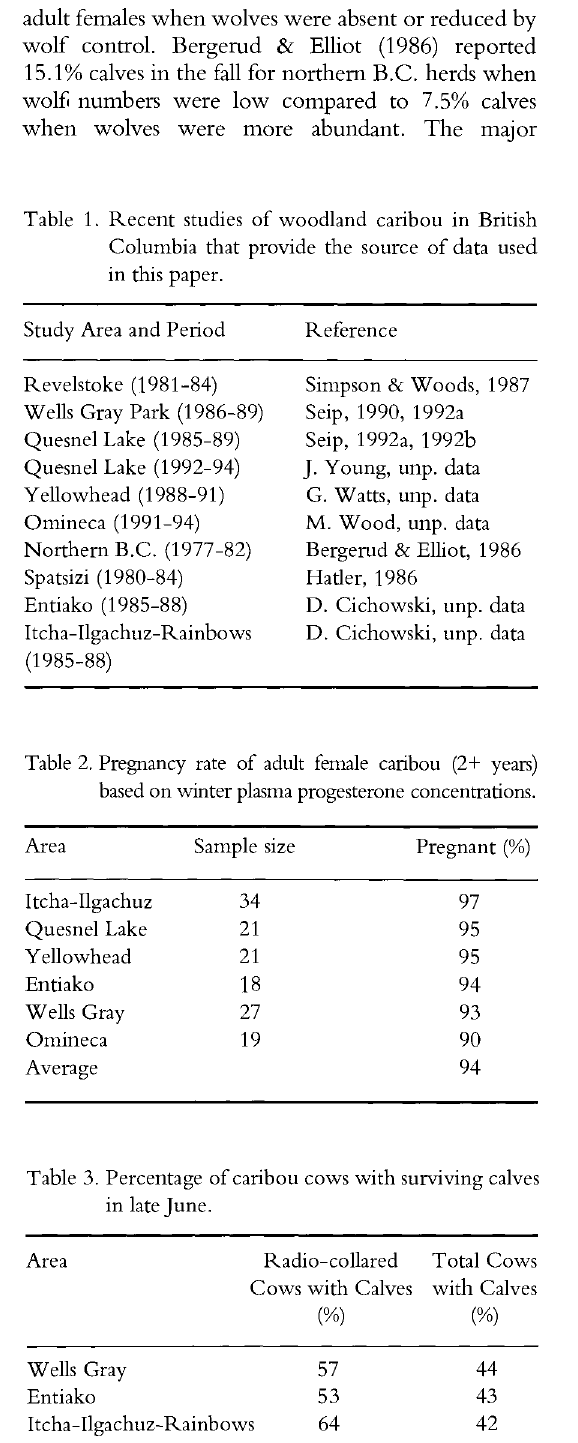
Table 3. Percentage of caribou cows with surviving